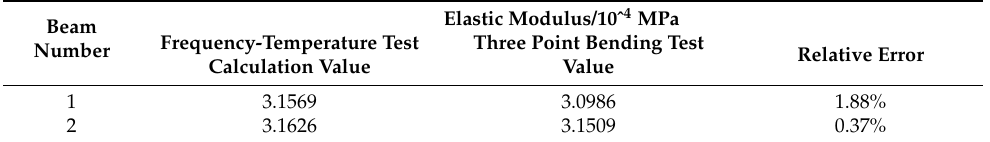
Table 2. Comparison of the elastic modulus measured by different methods (20 °C).